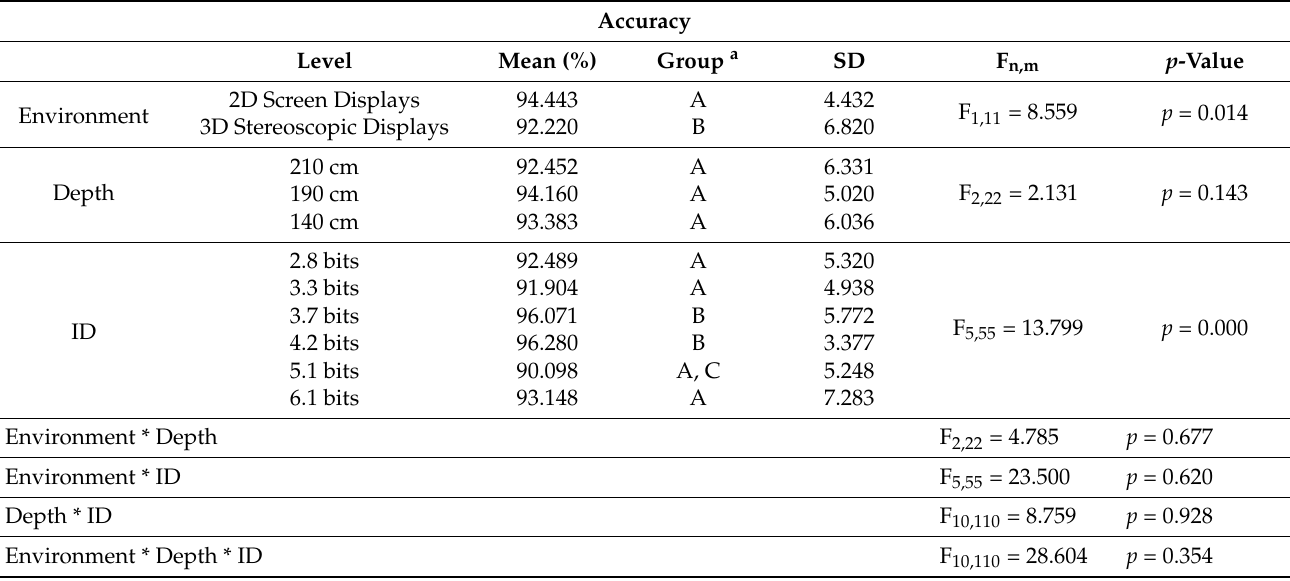
Table 9. Means, SDs, ANOVA, and Tukey HSD test results of eye fixation